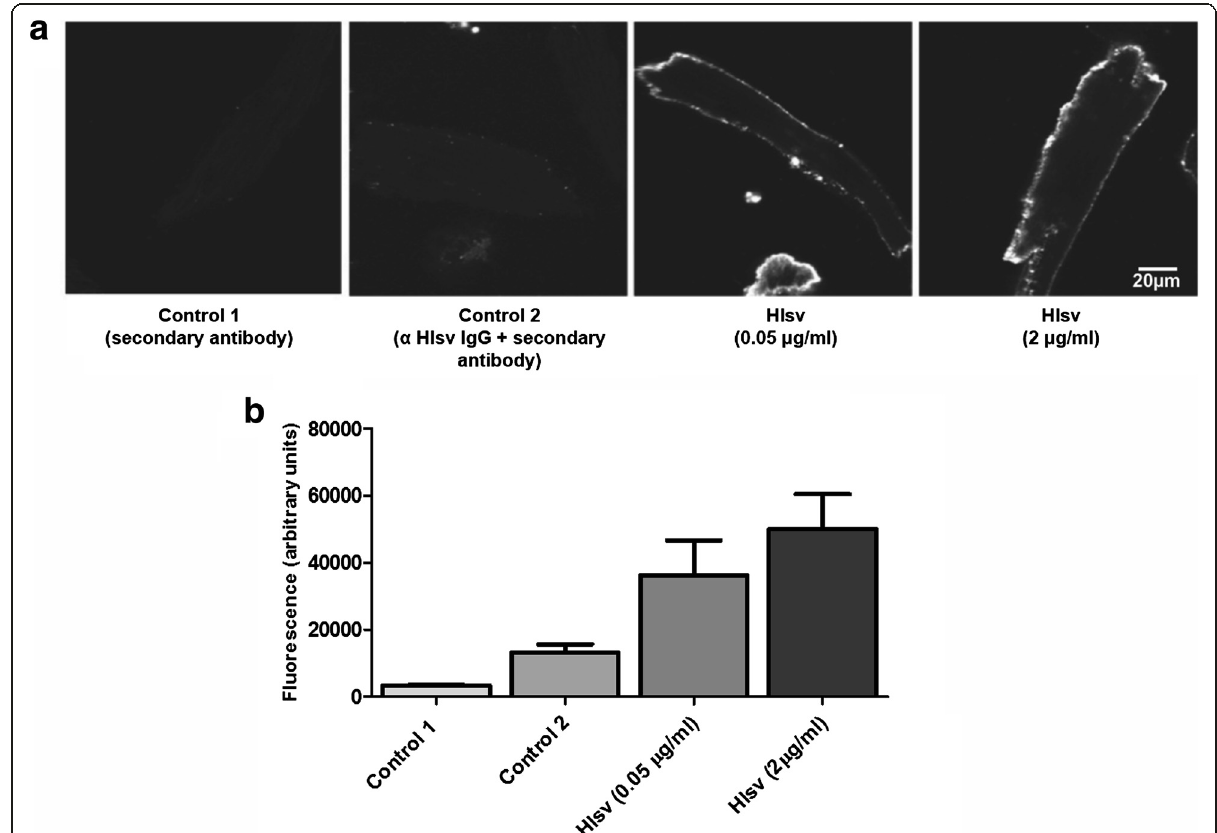
Fig. 5 Immunolocalization of Hlsv in isolated mouse cardiomyocytes. a Localization of Hlsv detected with anti- Hlsv IgGs in ventricular myocytes. Cells were treated with Hlsv , incubated with anti- Hlsv IgGs antibodies, followed by anti-rabbit IgG conjugated to Alexa Fluor 488 (Invitrogen, USA). As control, cardiomyocytes were treated only with secondary antibodies (control 1) or with IgG anti- Hlsv + secondary antibodies (control 2). Seven cells were analyzed in each group. b Bar graph shows the concentration-dependency of venom binding to cardiac